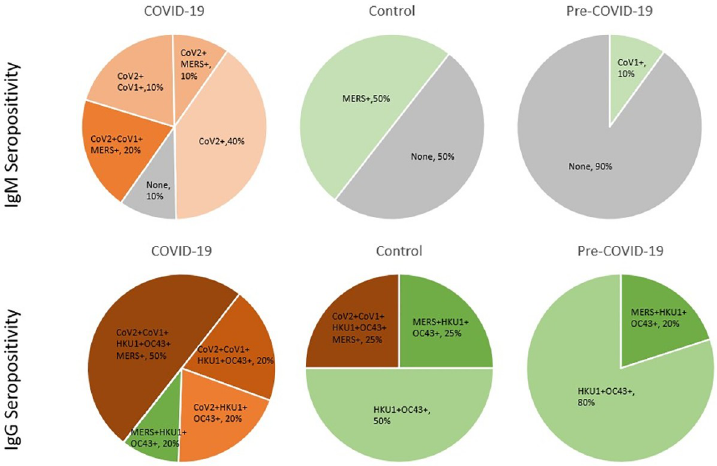
Fig 3. Seropositivity Pan-CoV in IgM and IgG responses. Pie charts showing percentage of subjects in the COVID- 19 (left), Control (center), and Pre-COVID-19 (right) groups that are seropositive to each combination of CoV spike antigens for SARS-CoV-1, SARS-CoV-2, MERS-CoV, HKU1, and OC43, with ‘+’ denoting seropositivity for the IgM (top) and IgG (bottom) responses. SARS-CoV-2 seropositivity is reflected by shades of orange, non-SARS-CoV-2 seropositivity is shown in shades of green, and no seropositivity to any CoV antigen is shown in gray.